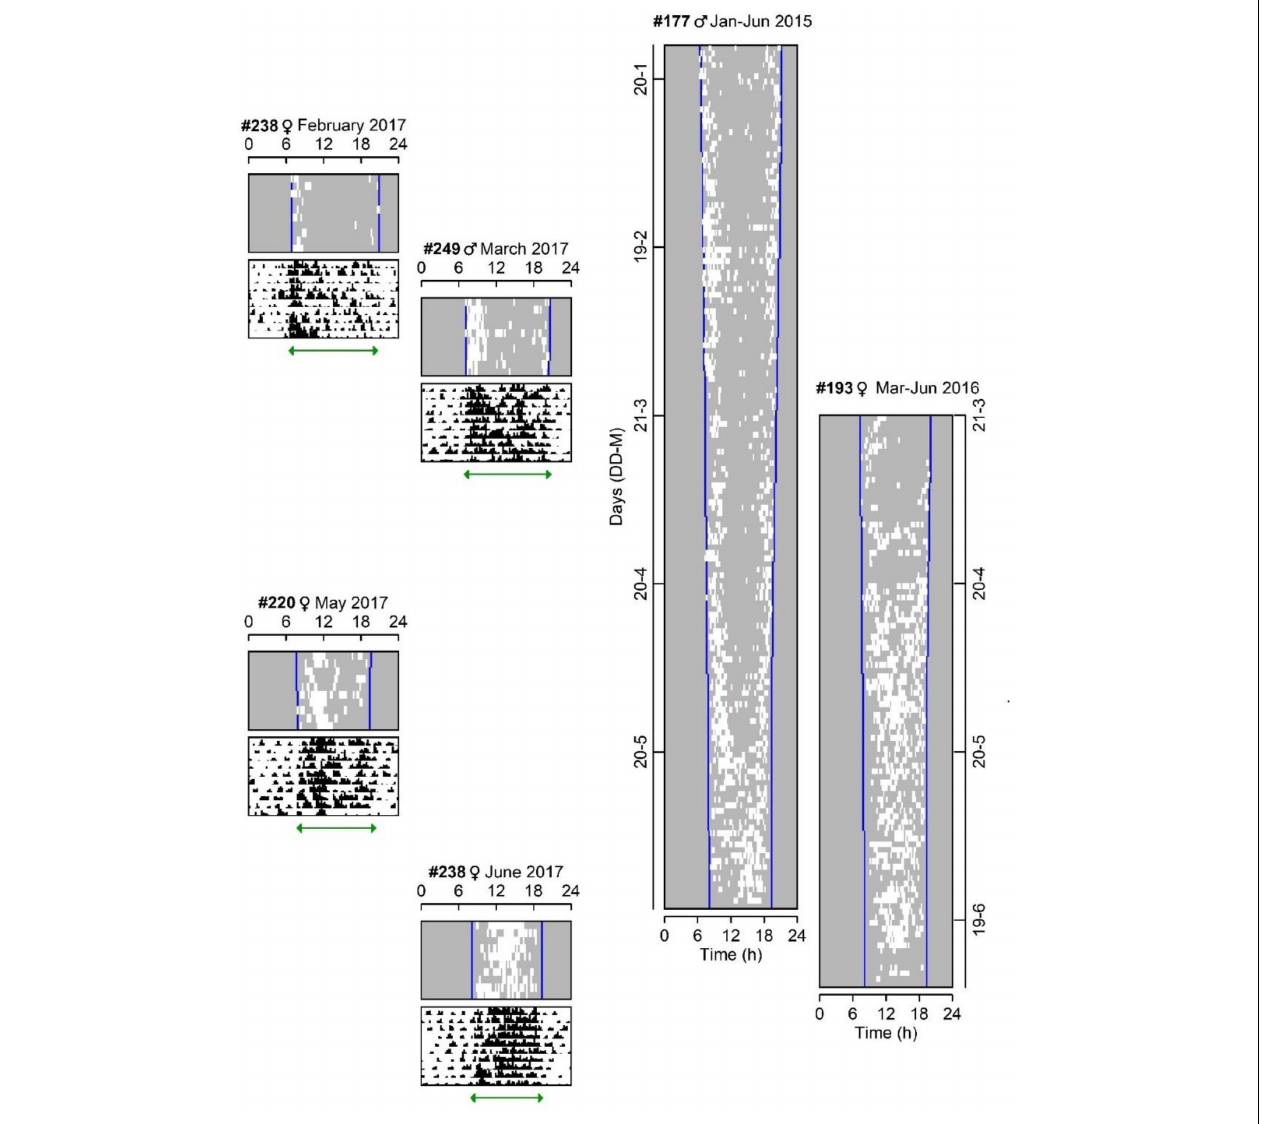
FIGURE 1 | Daily light exposure and activity patterns of individual tuco-tucos released in semi-natural enclosures from summer to winter. Actograms are positioned according to the annual timescale. The duration of the recordings was different for each animal. Left: Four shorter recordings (10 days), from individuals released in the enclosures throughout 2017, showing light exposure (white marks) and simultaneously recorded general activity (black marks). Green horizontal arrows indicate field-activity duration of each animal—#238 (Feb): 13.8 ± 1.7 h; #249 (Mar): 14.1 ± 0.8 h; #220 (May): 12.3 ± 0.5 h; #238 (Jun): 11 ± 0.5 h. Summer and winter field-activity durations were statistically different ( n = 6, Student’s t -test p = 0.02). Right: Two individuals with long term recordings of light exposure (white marks)—#177 from January to June 2015 and #193 from March to June 2016. Light exposure records indicate the time of surface emergences during sunlight hours (between civil twilight limits—blue vertical lines). Data of animals #177, #193, #220, #238 were taken from Jannetti et al.